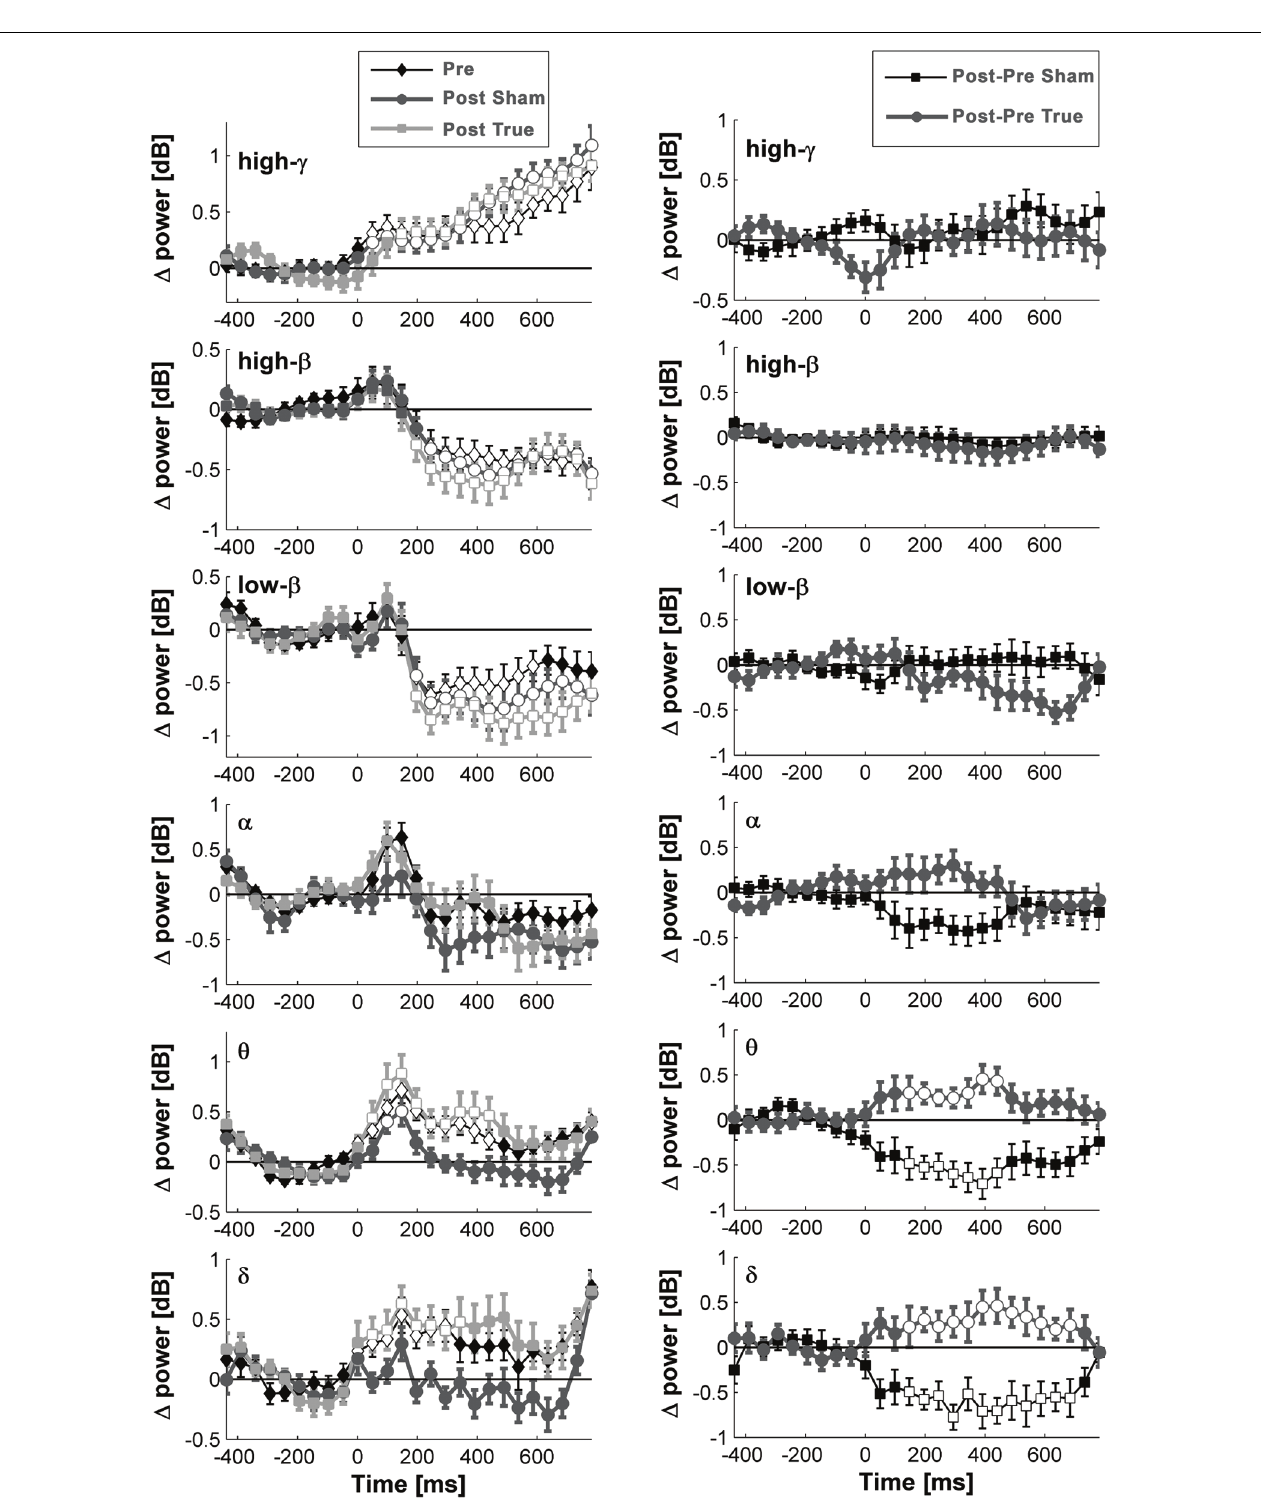
FIGURE 6 | Naming- and stimulation-related power modulations at the left temporo-occipital ROI. The left column shows power modulations (mean ± standard error of mean) before (pre) and after each type of stimulation (post), relative to baseline. The right column visualizes changes induced by stimulation. Empty symbols represent significant time windows ( p < 0.05, corrected). Theta and delta power increased 1 day after true cTBS, whereas the opposite was observed after sham stimulation.